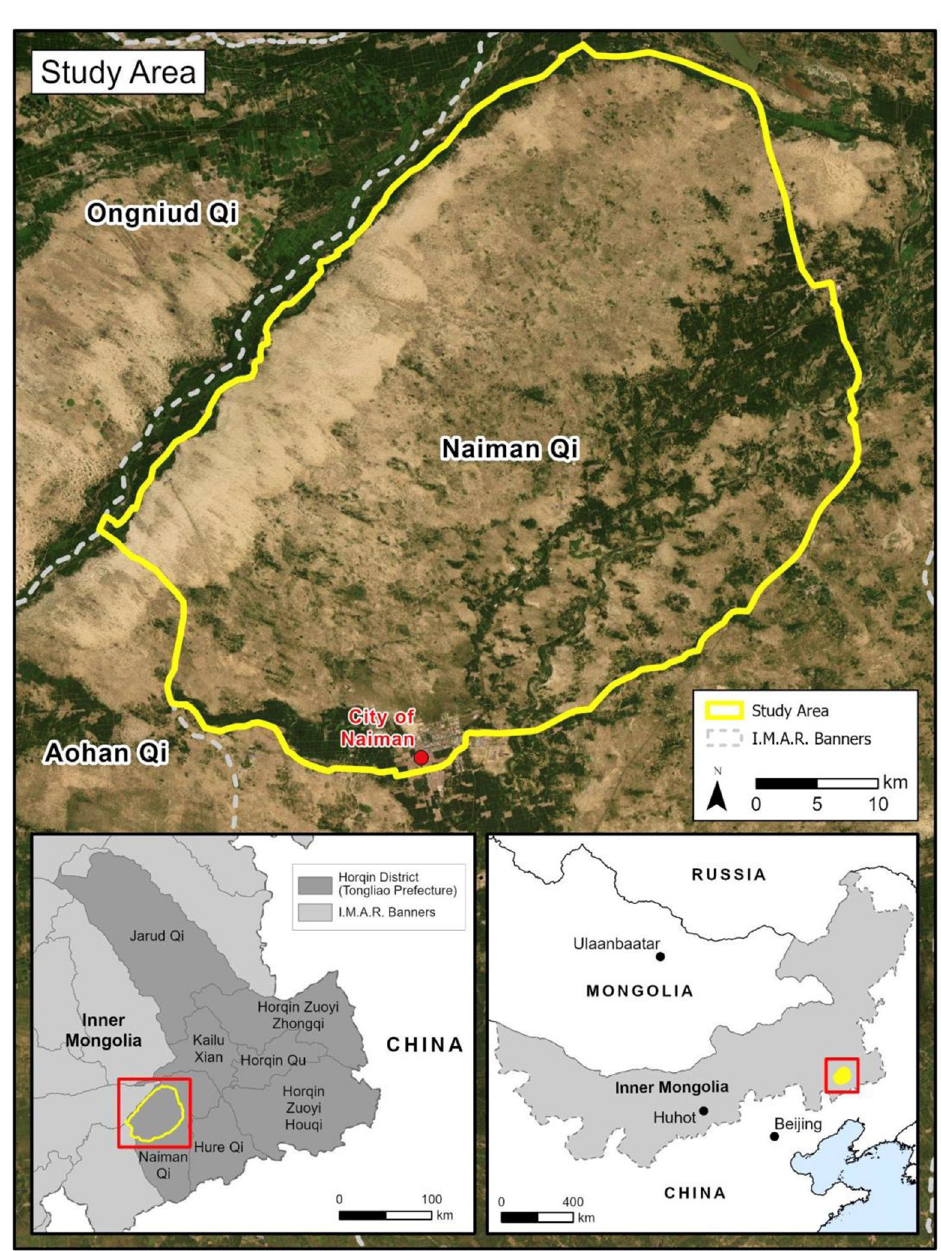
Figure 1. Satellite view of the focal study area and the location within China (red box).